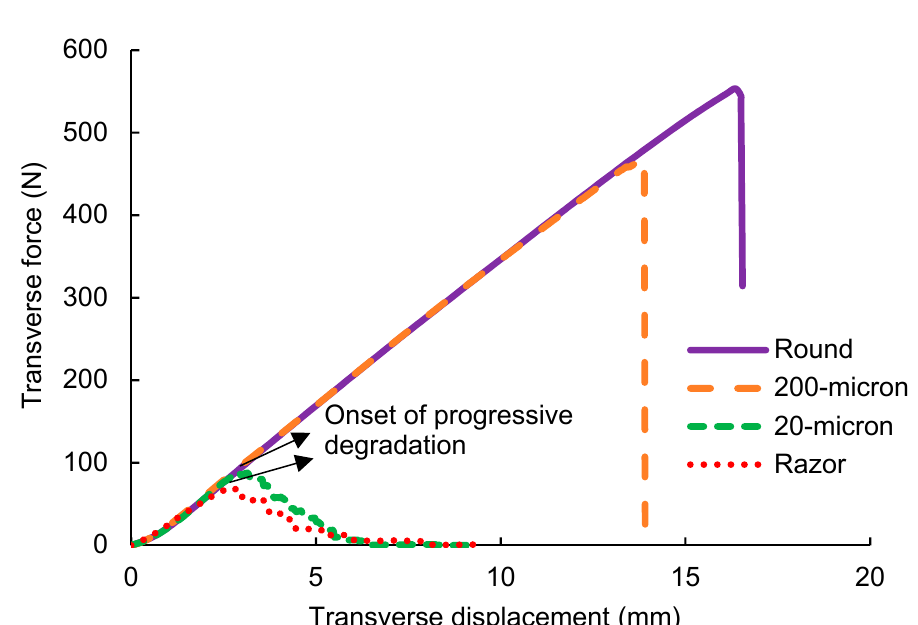
Figure 4. Representative transverse force vs. displacement response at θ start = 25 ◦ for di ff erent indenter geometries.